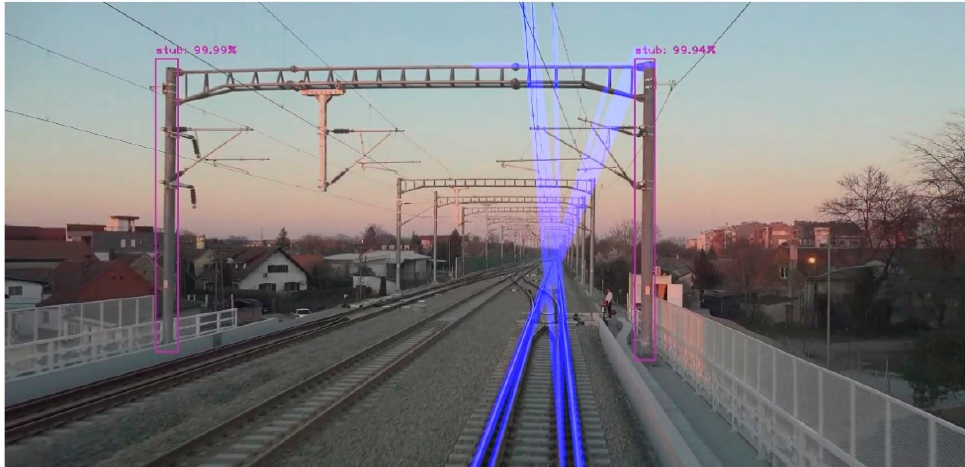
Figure 17. Overhead system detection—catenary rail lines and contact line mast—test image 2.